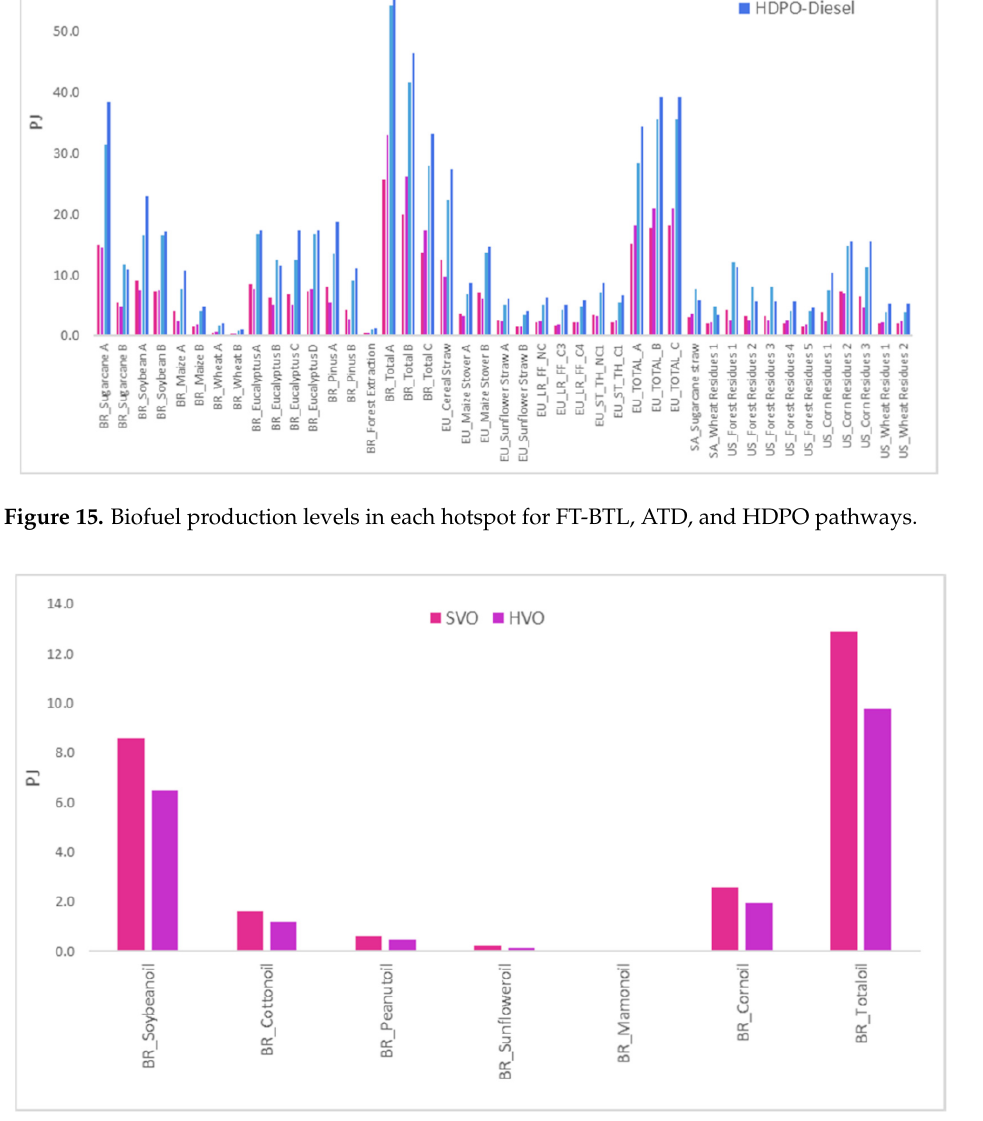
Figure 16. Biofuel production levels in each hotspot for SVO and HVO pathways. Note: BR_Mamonoil potential is